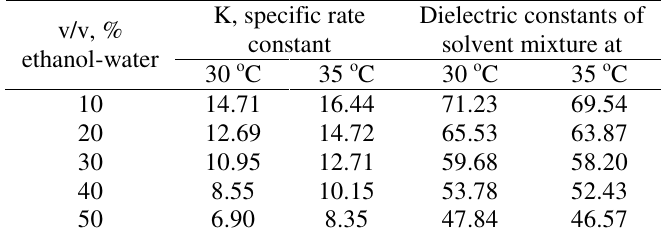
Table 1. Specific constant values of vinyl acetate in water-ethanol mixture.